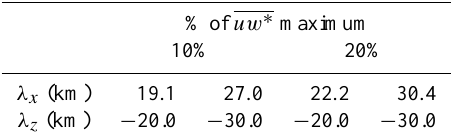
each of these bins determined from Eq. (66) in Fig. 14a and b, respectively. The GWs from left to right in Table 2 are shown as diamonds, triangles, squares, and x’s, respectively.